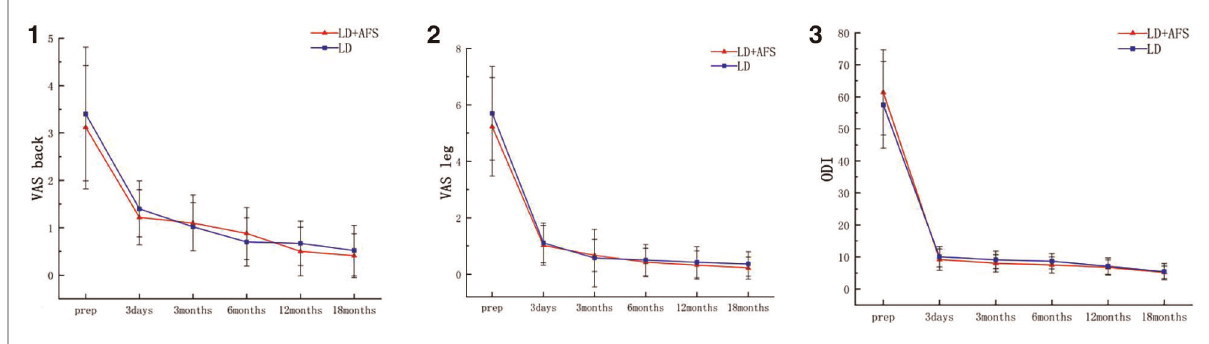
FIGURE 3 Changes in the visual analog scale (VAS) pain scores for the back (1) and leg (2), and in the Oswestry Disability Index (ODI) (3). LD+AFS: full- endoscopic annulus fi brosus suture following lumbar discectomy, AFS: annulus fi brosus suture.